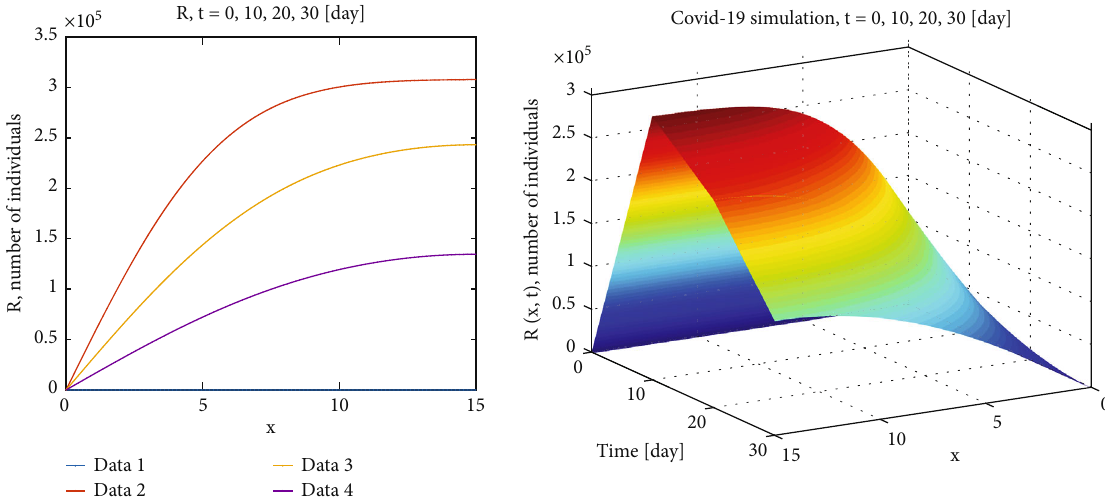
Figure 4: One section and 3-dimensional plot for the proportion of recovered persons who have been treated of COVID-19 in space and time.